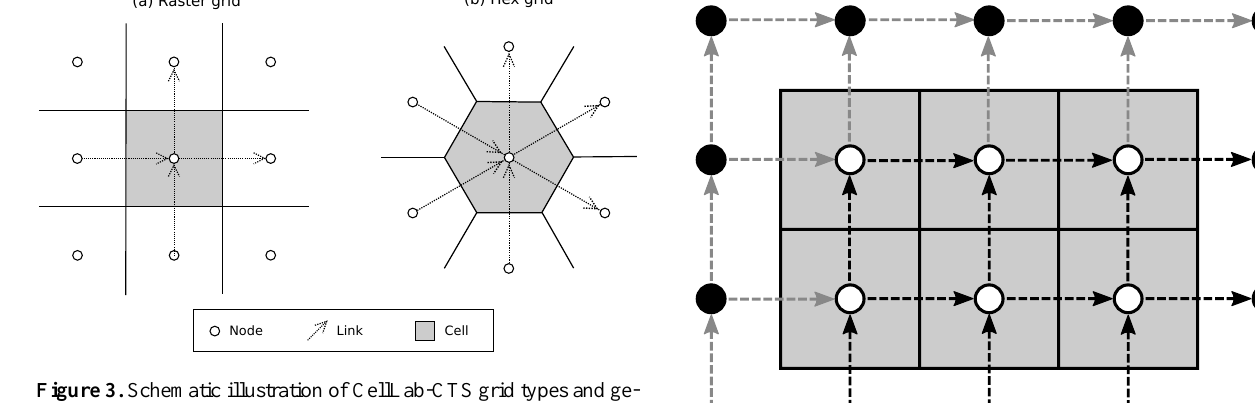
To facilitate boundary-condition handling, nodes come in two flavors: core nodes and boundary nodes (Fig. 4). Core nodes are those that constitute the computational